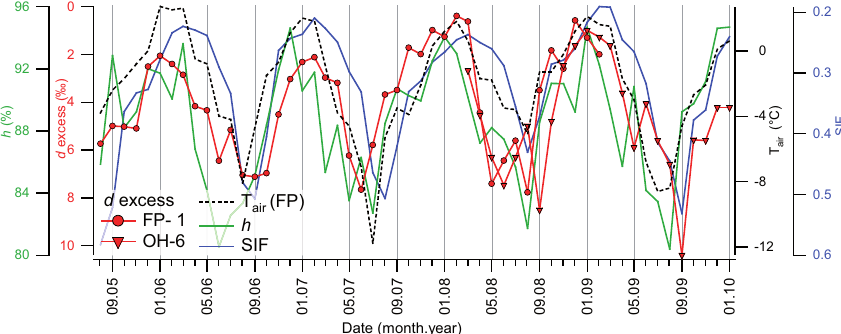
Fig. 14. Seasonal variation of monthly means of d excess of cores FP-1 and OH-6 compared to the meteorological variables: relative humidity ( h , green line), T air Bellingshausen station (FP, dashed black line) and sea ice fraction (SIF, blue line) for the Bellingshausen Sea. Note that the d excess and SIF axes are inverted for visualization purposes.